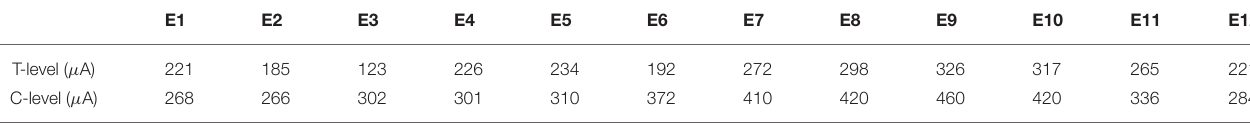
TABLE 3 | Post-implantation stimulus levels for a patient-specific case using